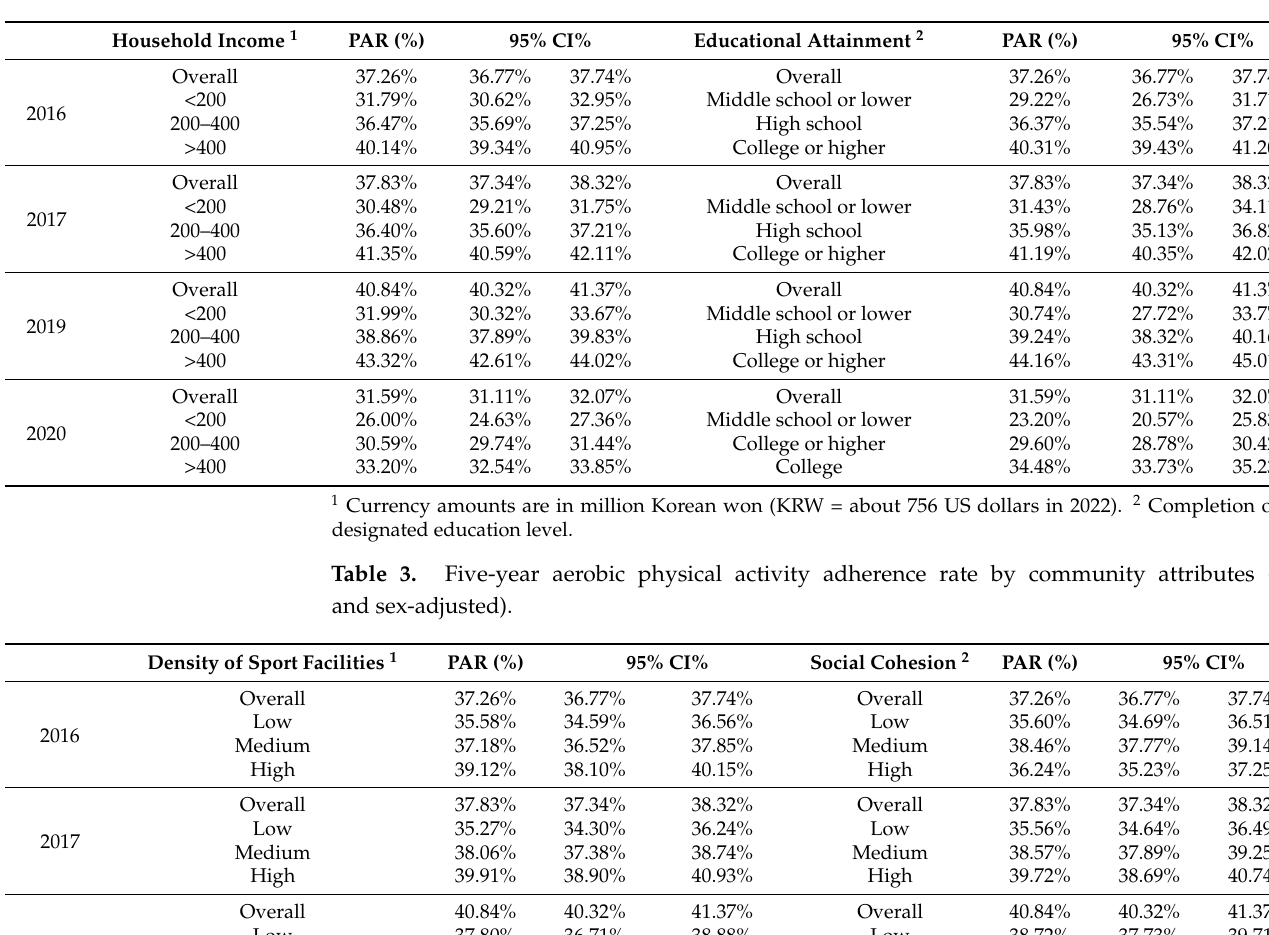
Table 2. Five-year aerobic physical activity adherence rate by socioeconomic status (age- and sex-adjusted).